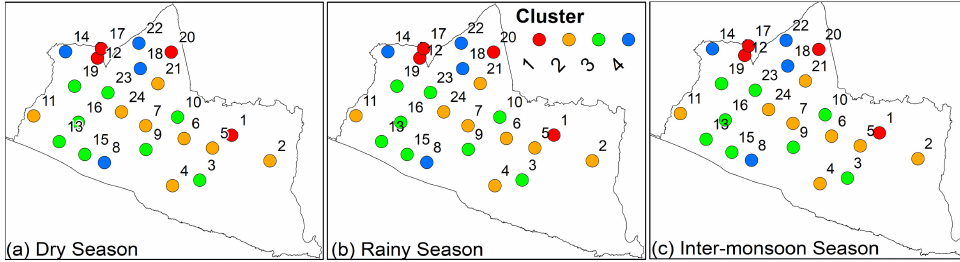
Figure 5. Results of HCA for rainfall stations classified into 4 group based on ( a ) dry season ( b ) rainy season ( c ) Inter-monsoon in Special Region Yogyakarta,